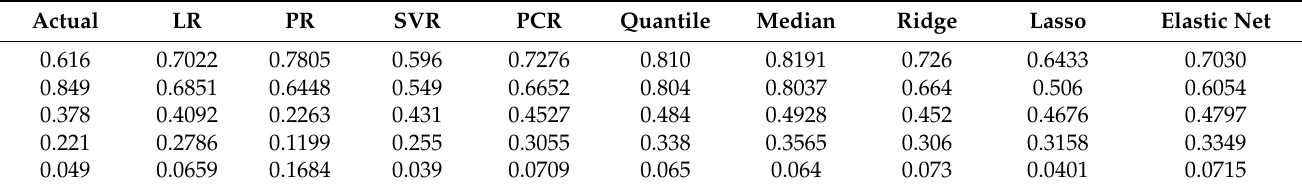
Table 3. Predicted Ra values based on the regression models in turning.